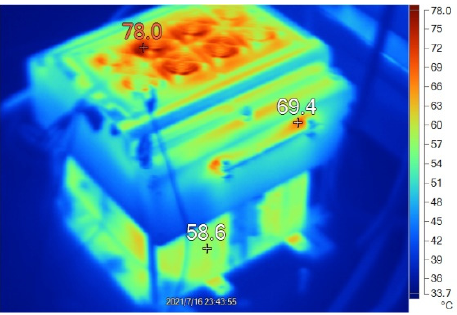
Figure 27. Temperature distribution measured by the infrared thermal camera.